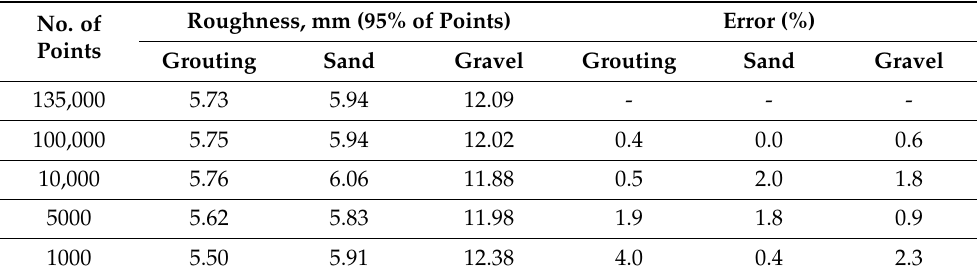
Table 1. Comparison of roughness between original point cloud and subsampled point clouds. Roughness, mm (95% of Points) Error (%) No. of Points